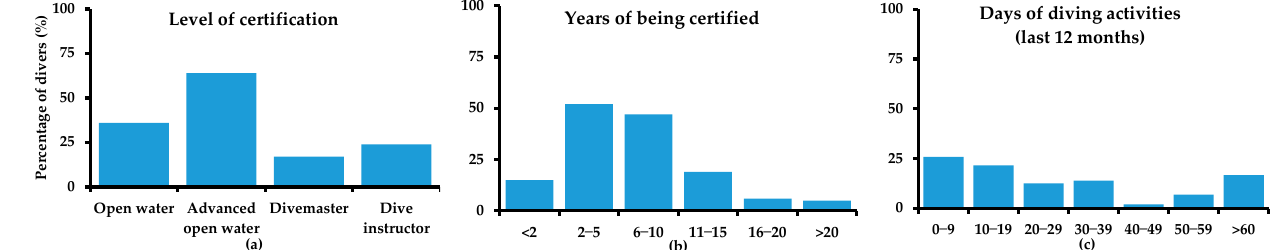
Figure 2. Diving experience of the participants: ( a ) level of certification; ( b ) duration of a SCUBA diver being certified; ( c ) days of diving activities during the last 12 months.